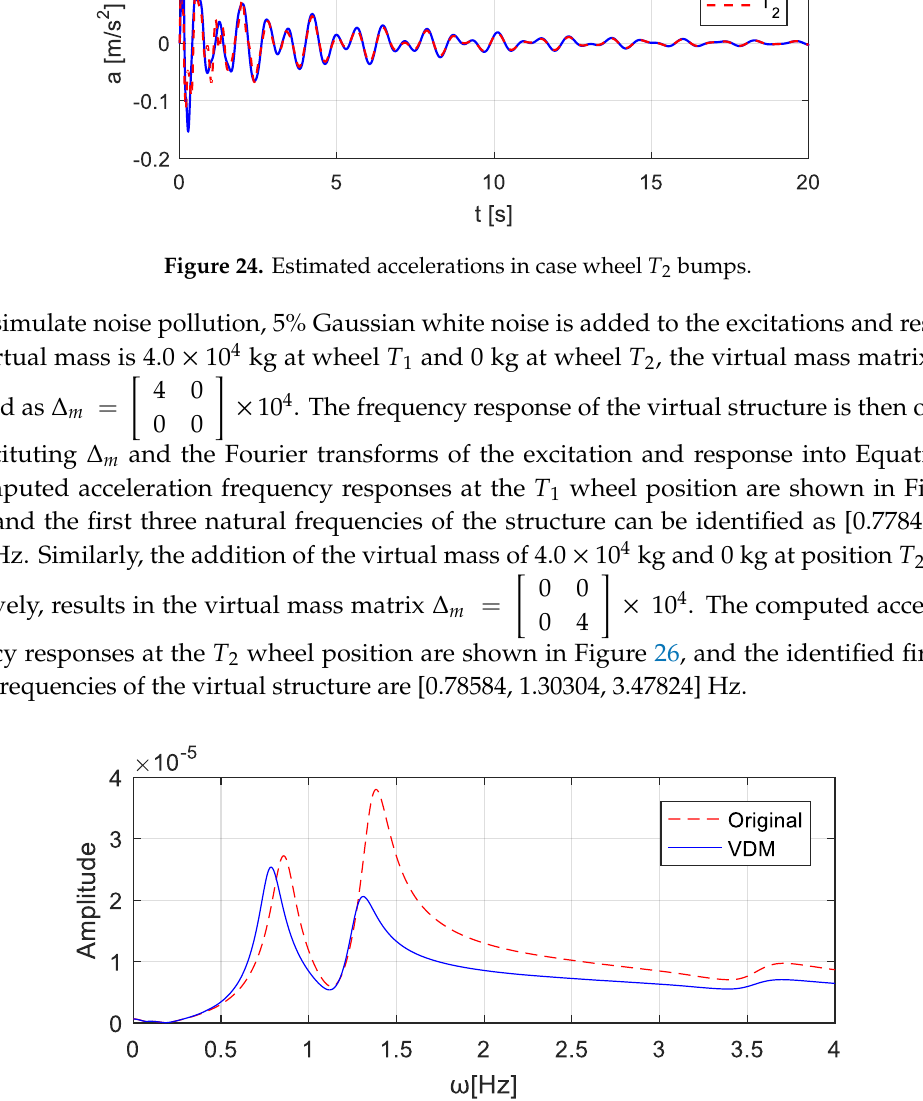
Figure 25. Acceleration frequency responses at T 1 wheel position with the virtual mass added to the wheel T 1 .